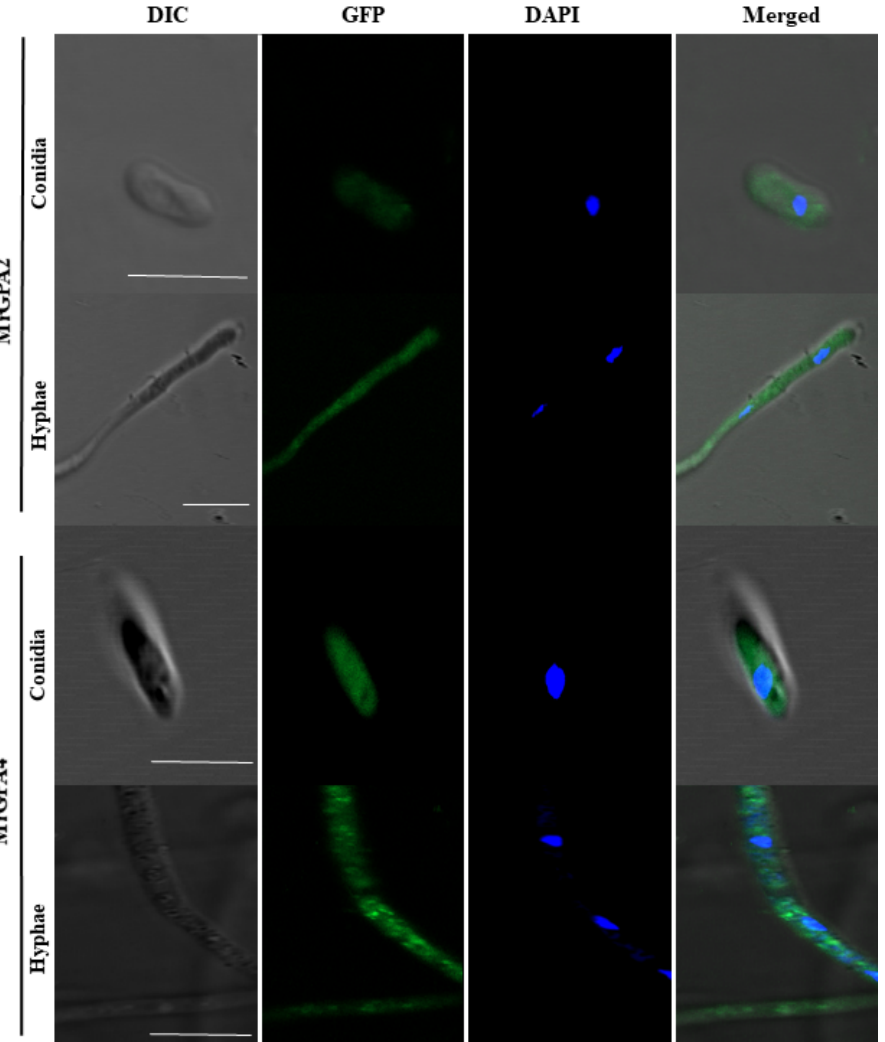
Figure 2. Localization of MrGPA2 and MrGPA4. The localization of MrGPA2 and MrGPA4 in hyphae and conidia, showing that MrGPA2 and MrGPA4 are located in the cytoplasm with the GFP fluorescence signal, scale bars: 10 µm.